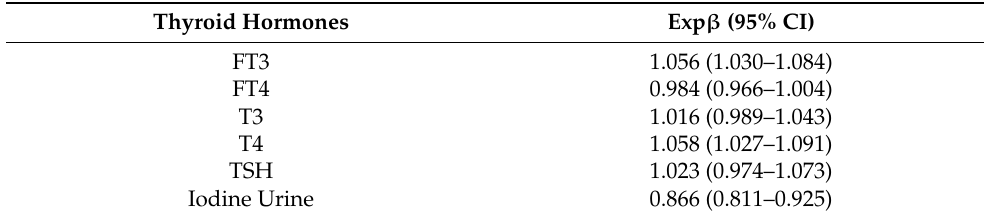
Table 4. Comparison of log (10) thyroid hormone levels for farmers versus non-farmers using a generalized linear model *.